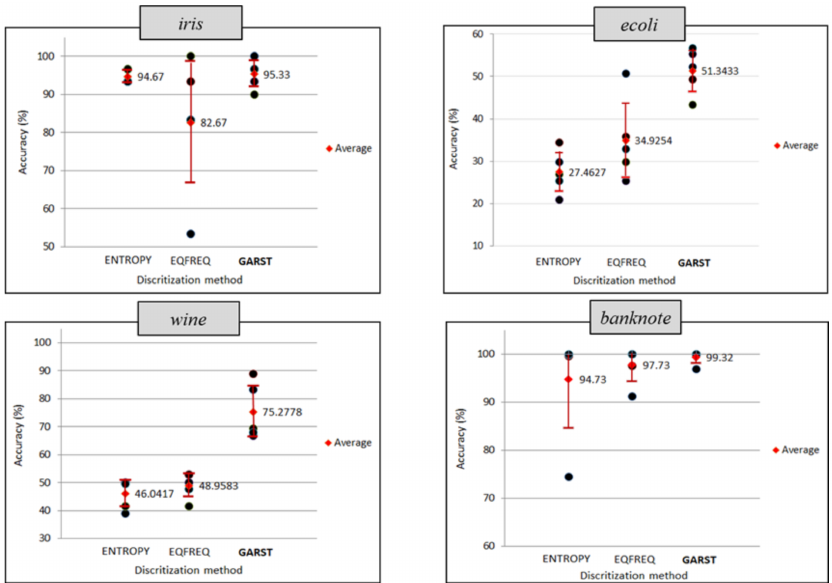
Figure 5. Plots showing the distribution of accuracy